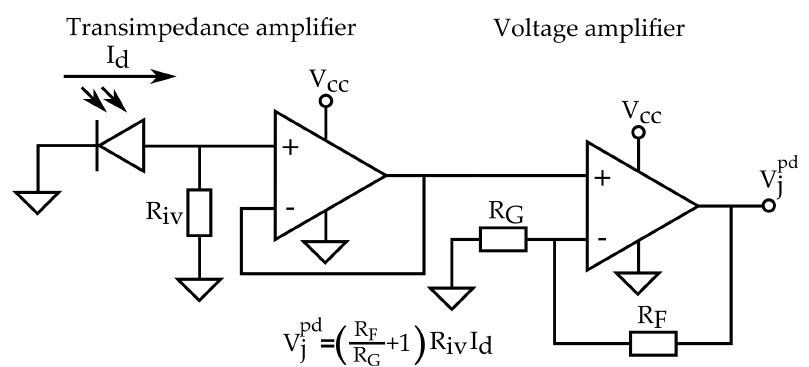
Figure 7. Signal conditioning circuit implemented for each individual photo-diode. The expression of the relation between output voltage ( V pd ) and current in the photodiode ( I d ) is shown. j Despite the outputs ( V pd ) being combined using analogical components in order to get only one j analog output, for this study, the sensor will output four voltages corresponding to each photo-diode. Output signals are read by the micro-controller throughout a multiplexed analog-to-digital converter (ADC) so that they can be added and subtracted digitally reducing the risk signal